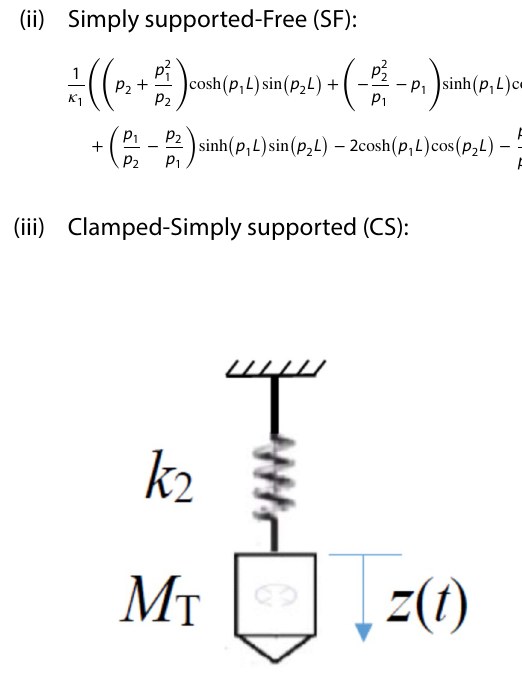
Fig. 8 Spring-mass system at x =